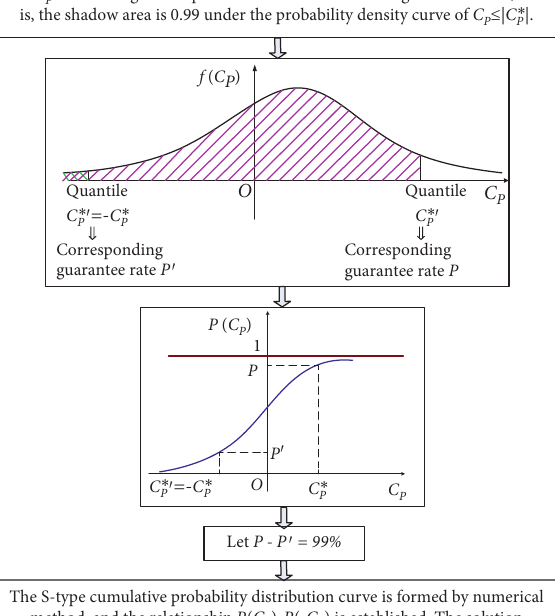
Figure 2: Bilateral guarantee rate